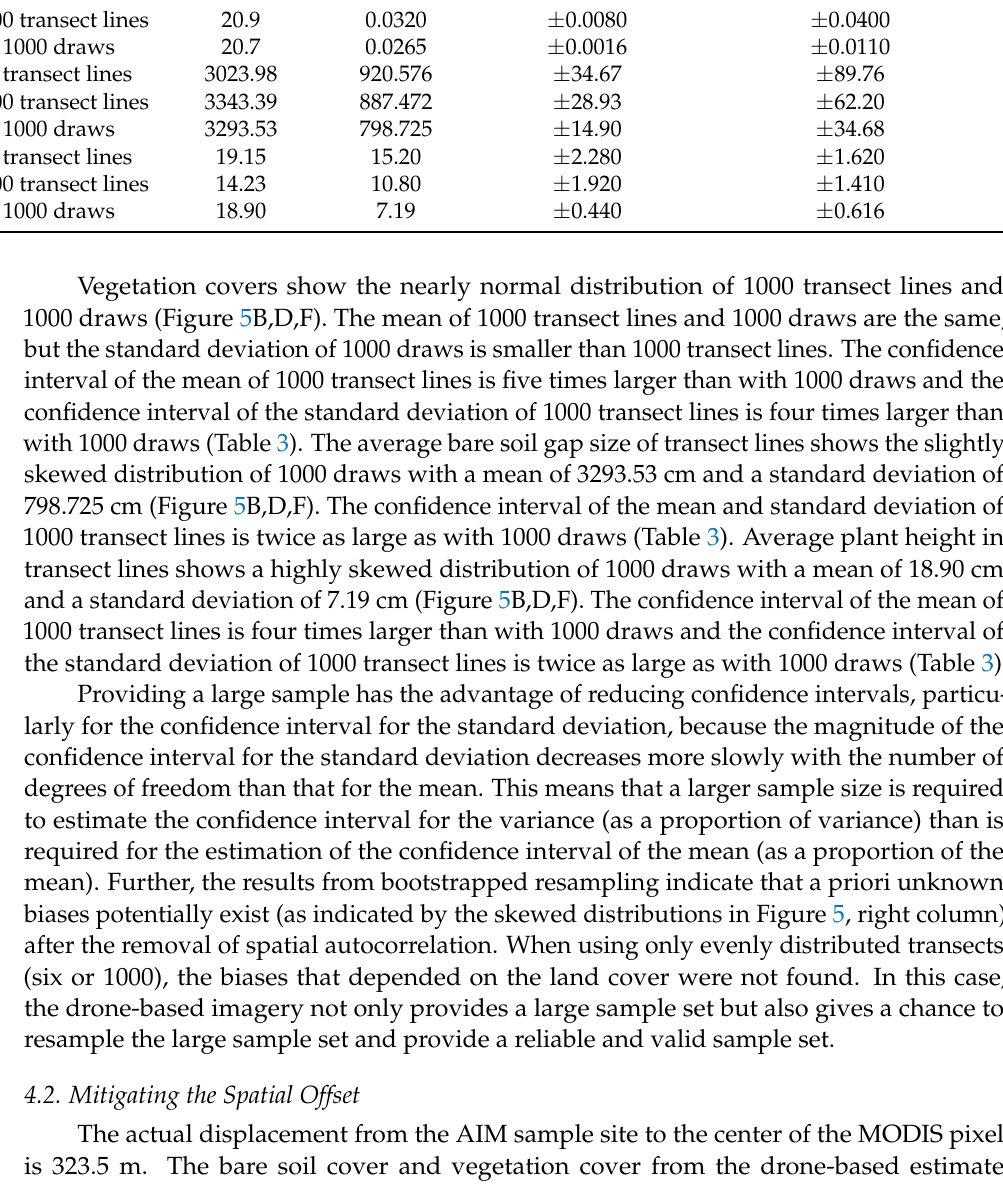
Standard Confidence Confidence Interval Mean Deviation Interval of Mean